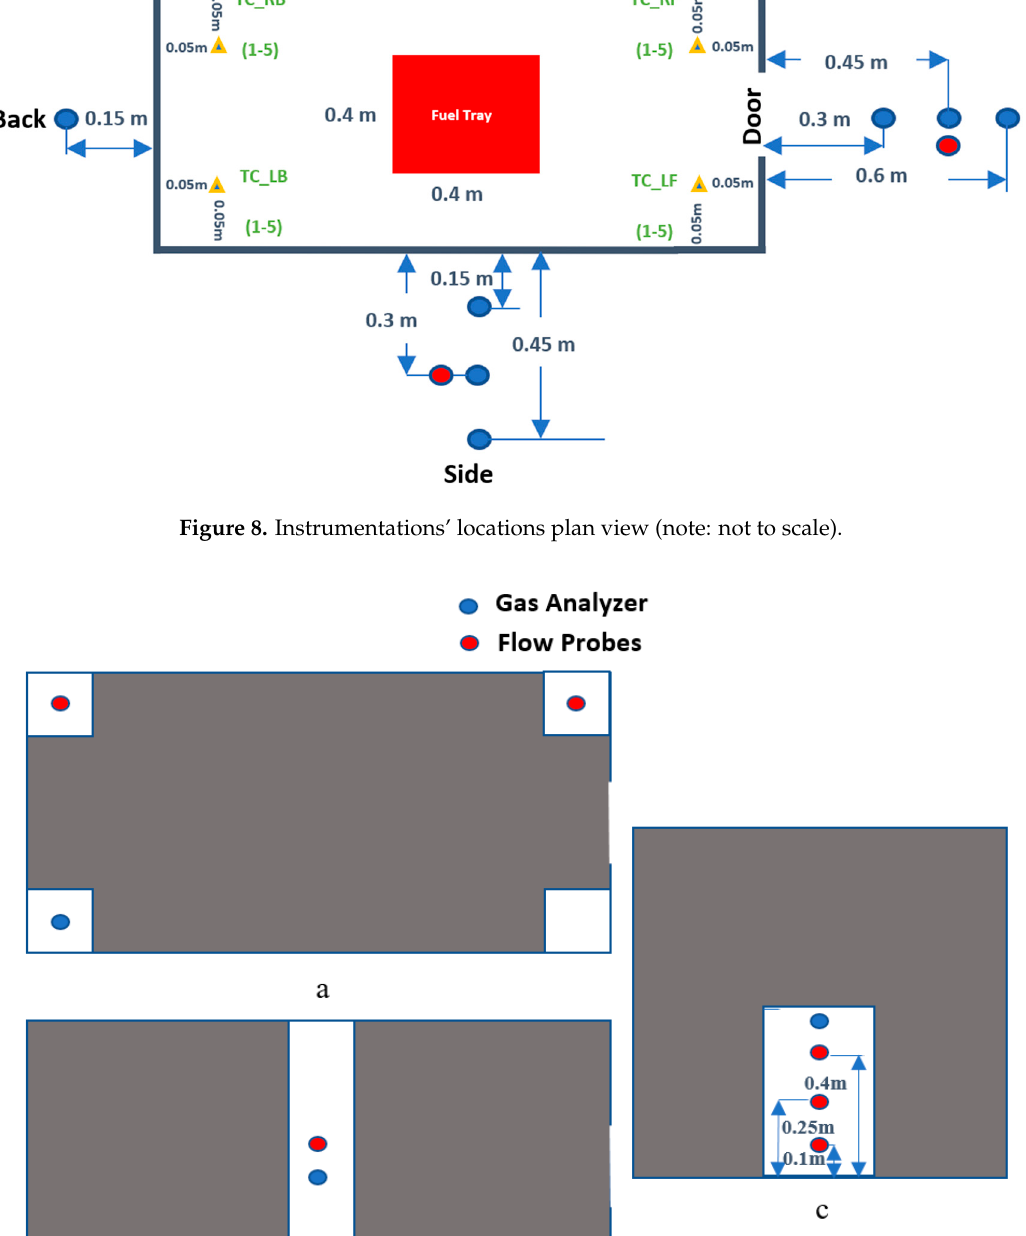
Figure 9. Gas analyser and flow probe locations in ( a ) roof plan for corner openings (with the gas analyser placed at same location as the top ThermoCouple (TC) in the Left Back (LB) tree and the flow probe placed at the plan of the horizontal opening); ( b ) roof plan for central slot horizontal opening (with the flow probe and the gas analyzer at the middle of the slot); and ( c ) door vertical opening (wall elevation shown) (with the gas analyser placed at the same location as the top flow probe) (NOTE: not to scale).